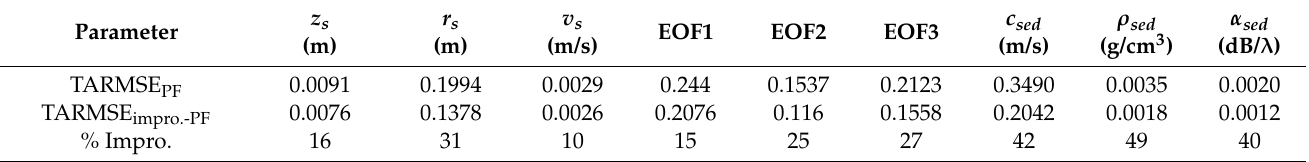
Table 2. Performance comparison for Example